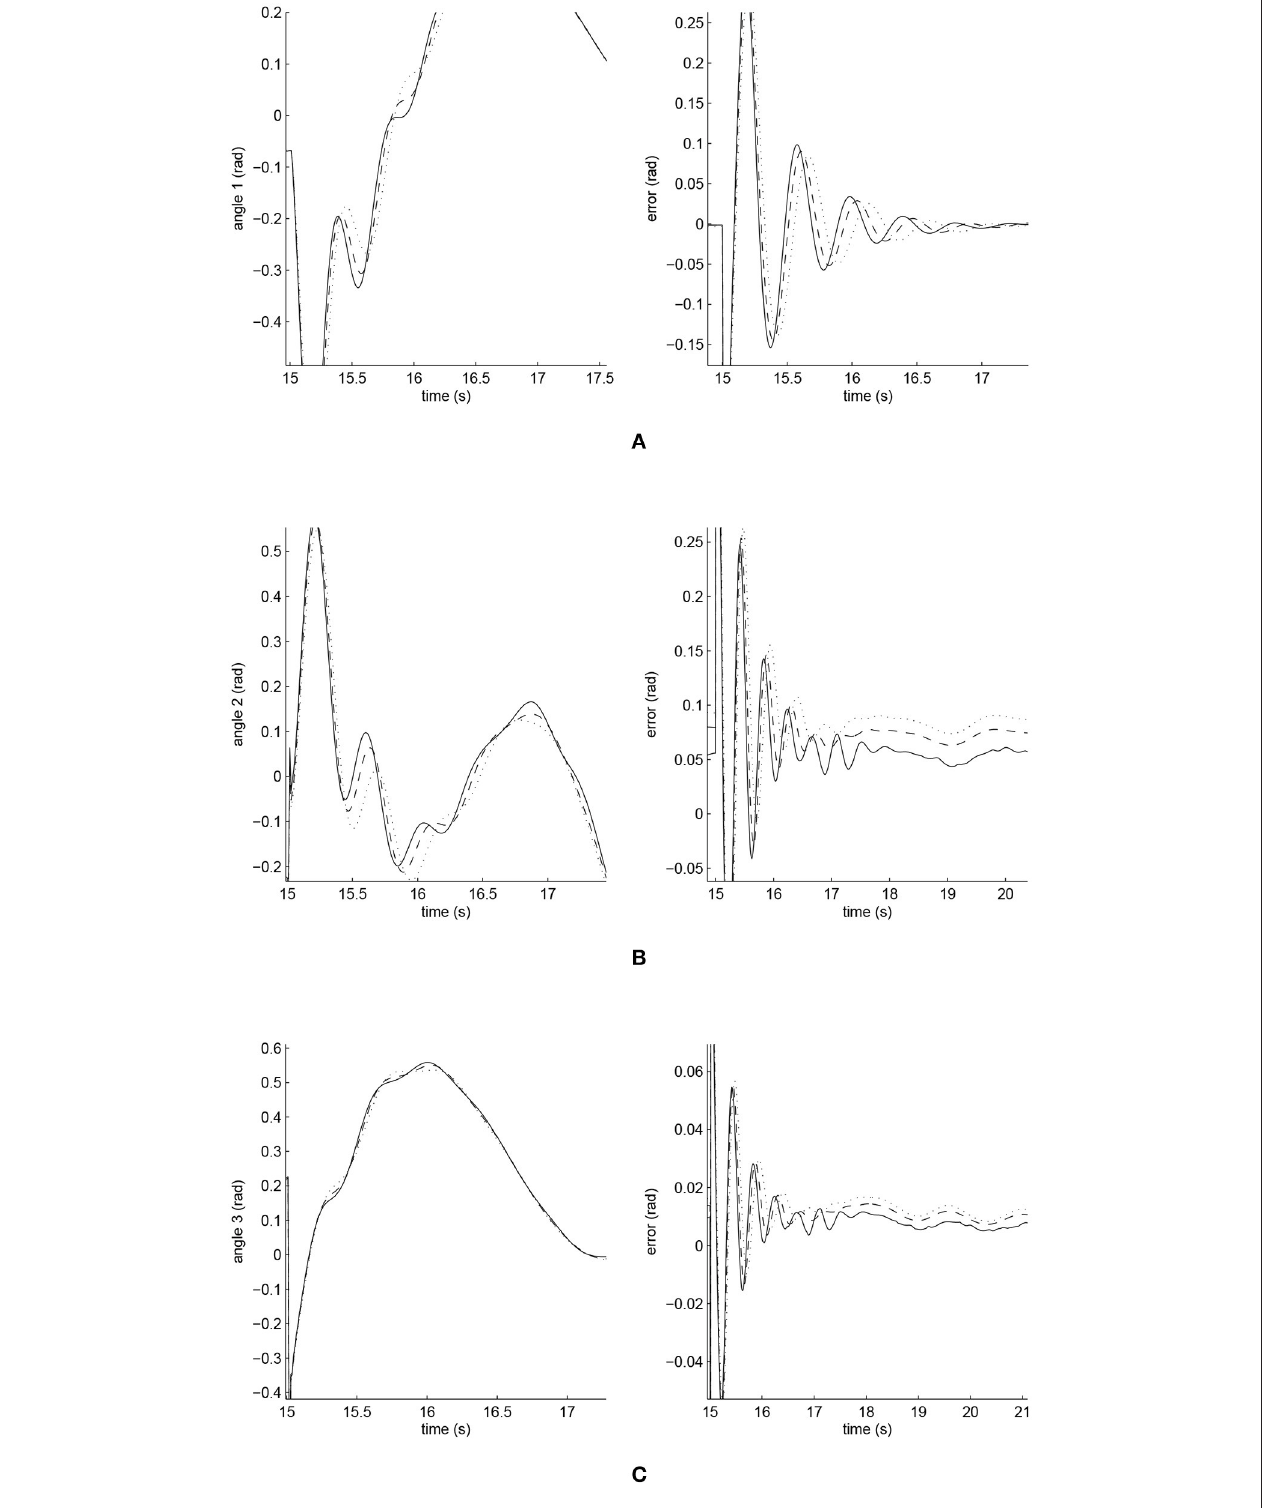
FIGURE 7 | Amplified trajectory responses (in the left) and tracking errors (in the right) at t = 15 of Joints 1, 2, and 3. The solid line indicates the performance of the iFBEL; the dotted line represents that of the PID controller; and the dot dash line implies that of the FCMAC controller. (A) Amplified trajectory response and tracking error of Joint 1. (B) Amplified trajectory response and tracking error of Joint 2. (C) Amplified trajectory response and tracking error of Joint 3.